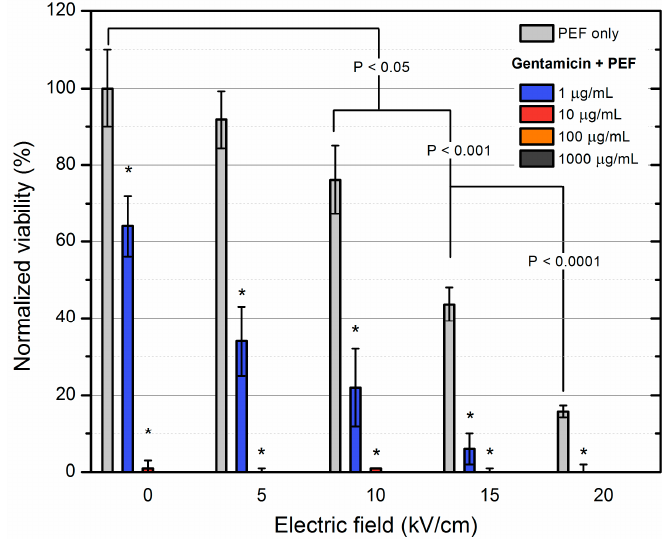
Figure 5. Inactivation of MRSA using electroporation separately and in combination with gentamicin of varied concentration. Asterisk (*) represents statistically significant ( p < 0.05) difference versus PEF only treatment. Gentamicin was the most effective antibiotic in the study and even the lowest concentration (1 μ g/mL) resulted in a significant additive effect for all PEF amplitudes.